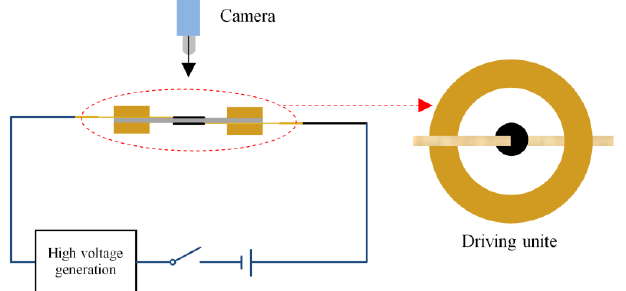
Figure 2. Schematic diagram of electrostrictive strain and electrical breakdown test.